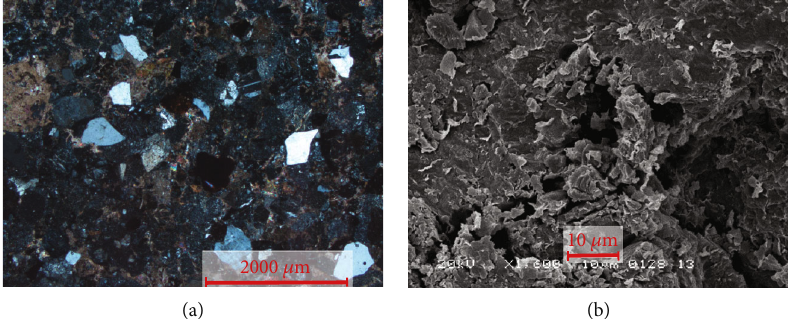
Figure 4: Microscopic characteristics of carbonate cementation features of sandy conglomerates from Triassic Baikouquan Formation in the slope of the Mahu Sag. (a) The thin-section feature of early calcite crystalline and (b) the scanning electron microscope (SEM) feature of early